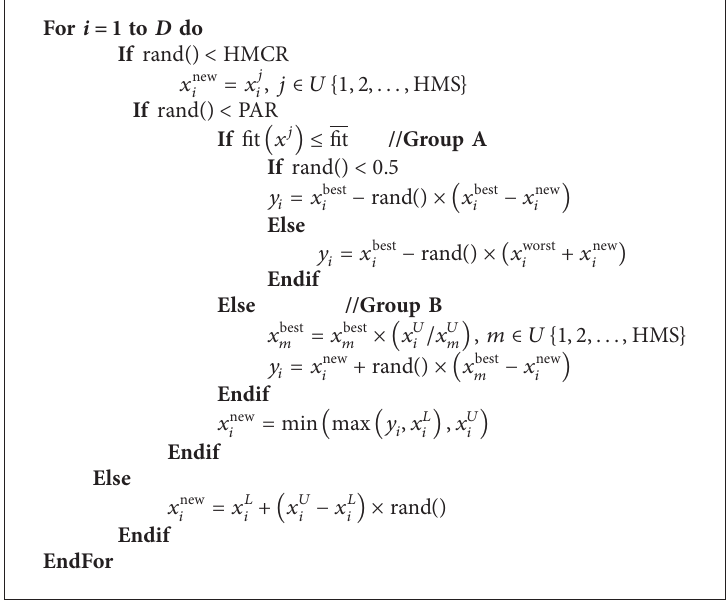
Algorithm 3: The improvisation procedure of new harmony by